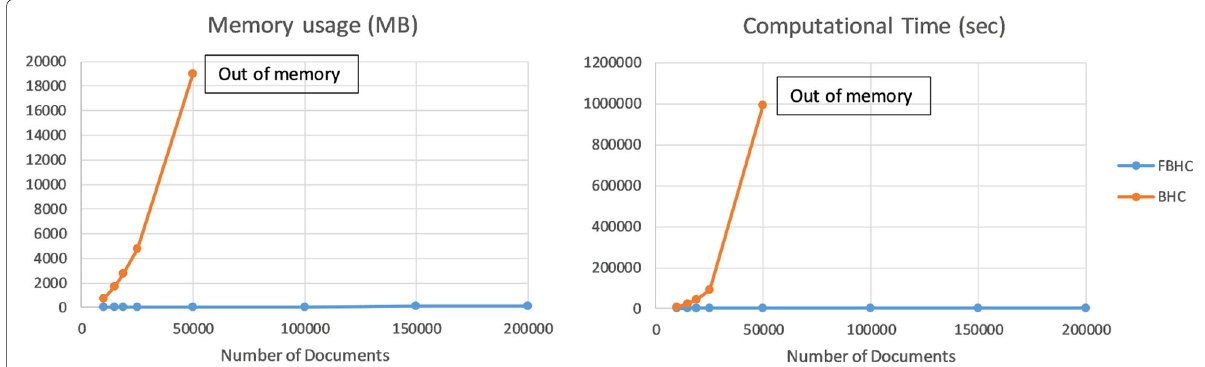
Fig. 2 Comparison of the FBHC and BHC algorithms using subsets of the NYTimes dataset, in terms of performance